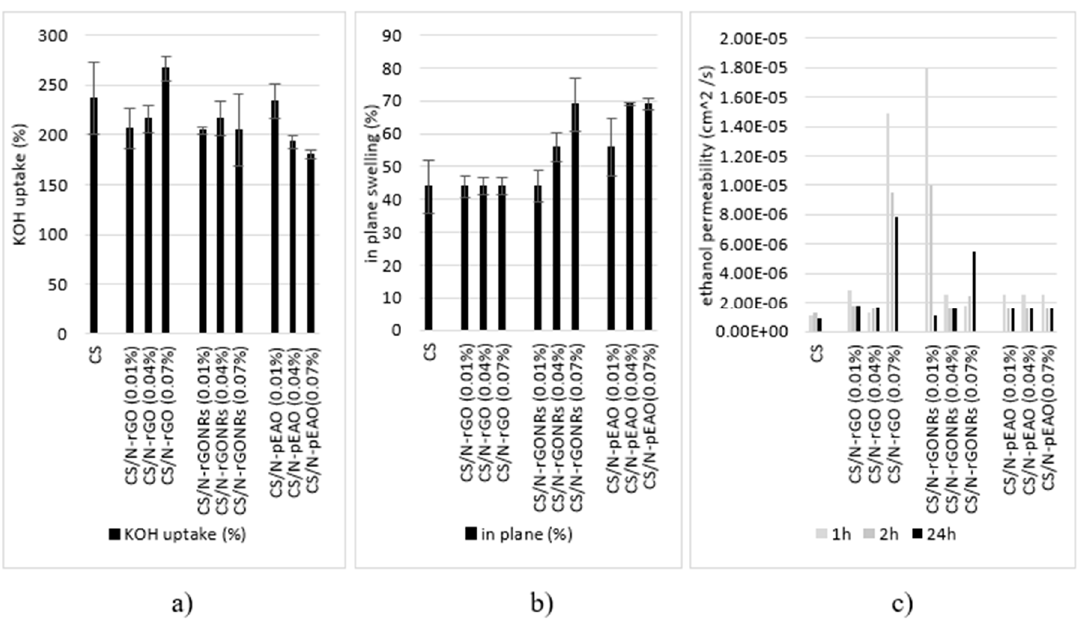
Figure 9. ( a ) KOH uptake (%) and ( b ) in-plane swelling (%) data, obtained after 24 h immersion in 6M KOH, and ( c ) ethanol permeability (cm 2 /s), obtained after 1 h, 2 h, and 24 h measurement within a constructed cell of neat CS and CS/graphene composite membranes, containing 0.01%, 0.04%, and 0.07% of N-rGO, N-rGONRs and N-pEAO, all estimated as a working temperature of 25 °C.